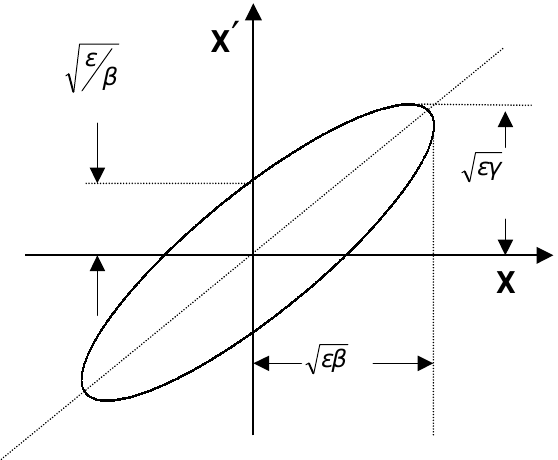
FIG. 9. Phase space ellipse. ´ is the geometric emittance, while a , b , and g are the Twiss parameters.